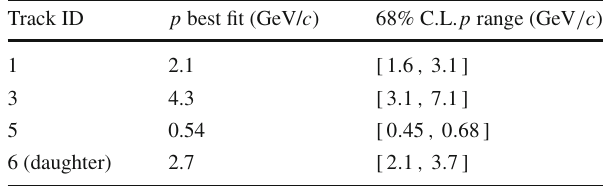
Table4 ParticlemomentareconstructedbythemultipleCoulombscat- tering